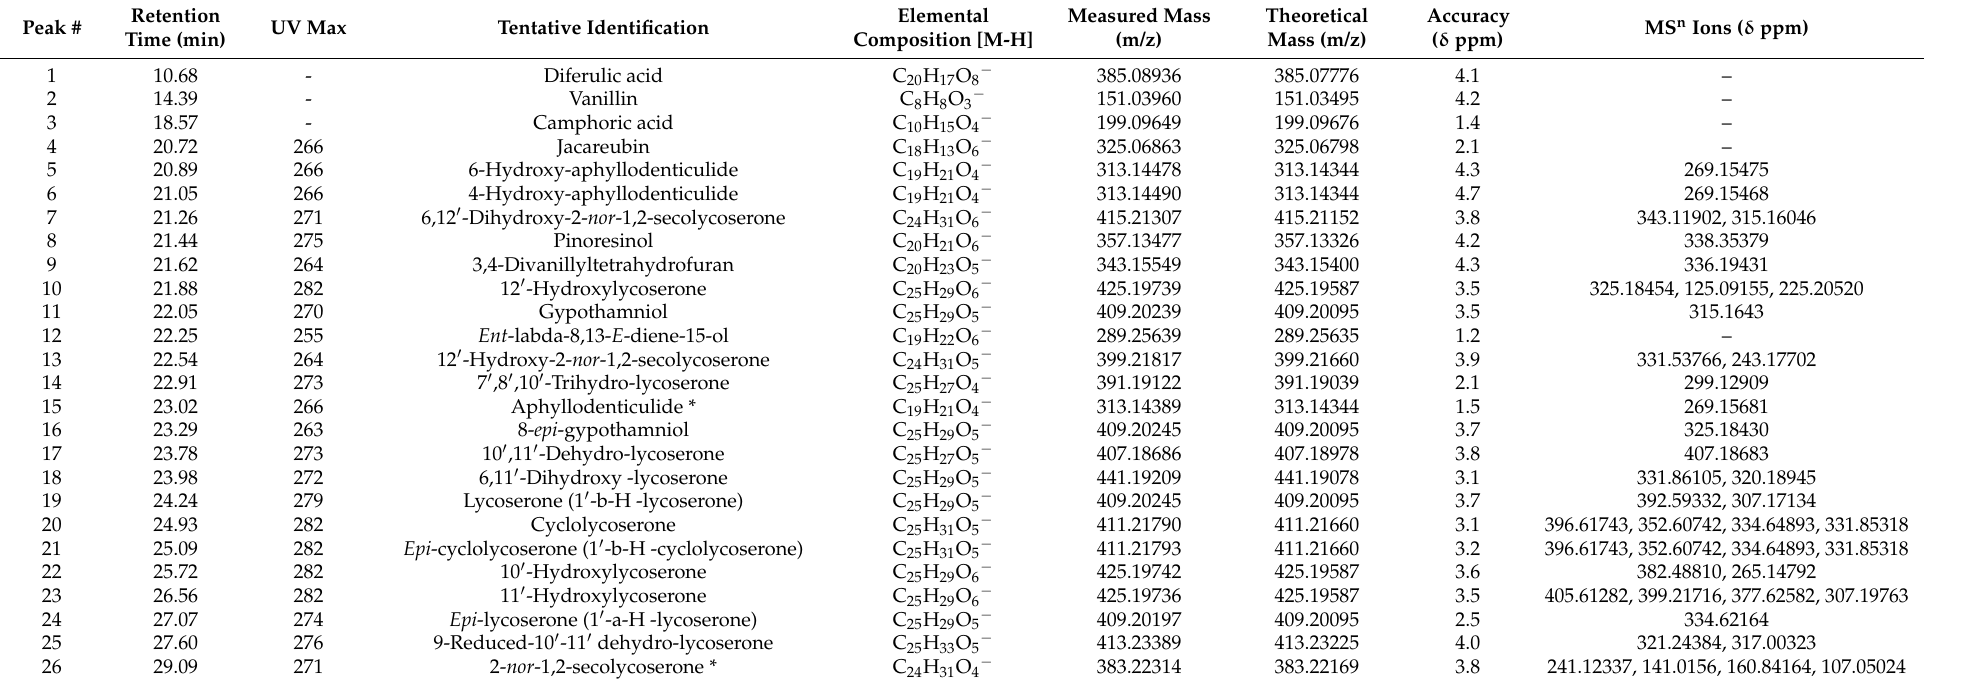
Table 1. Identification of phenolic compounds by HESI orbitrap HR-MS of Gypothamnium pinifolium